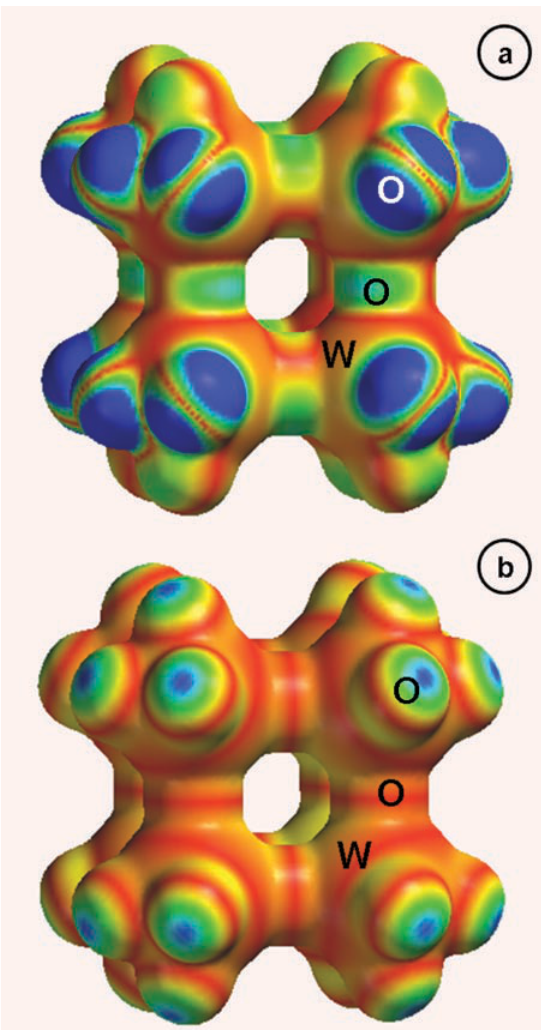
Figure 9. Electron density surface for a WO electrostatic potential map showing the actual capacity for cation intercalation; d = 0.002; color coded potential: from high – blue, to low - red.